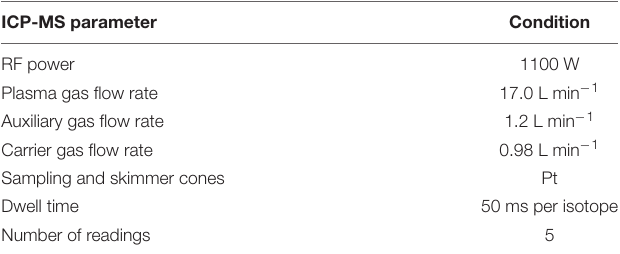
TABLE 2 | Limits of detection (LOD) and limits of quantification (LOQ) for each element investigated herein in green turtle ( Chelonia mydas ) muscle and kidney samples.